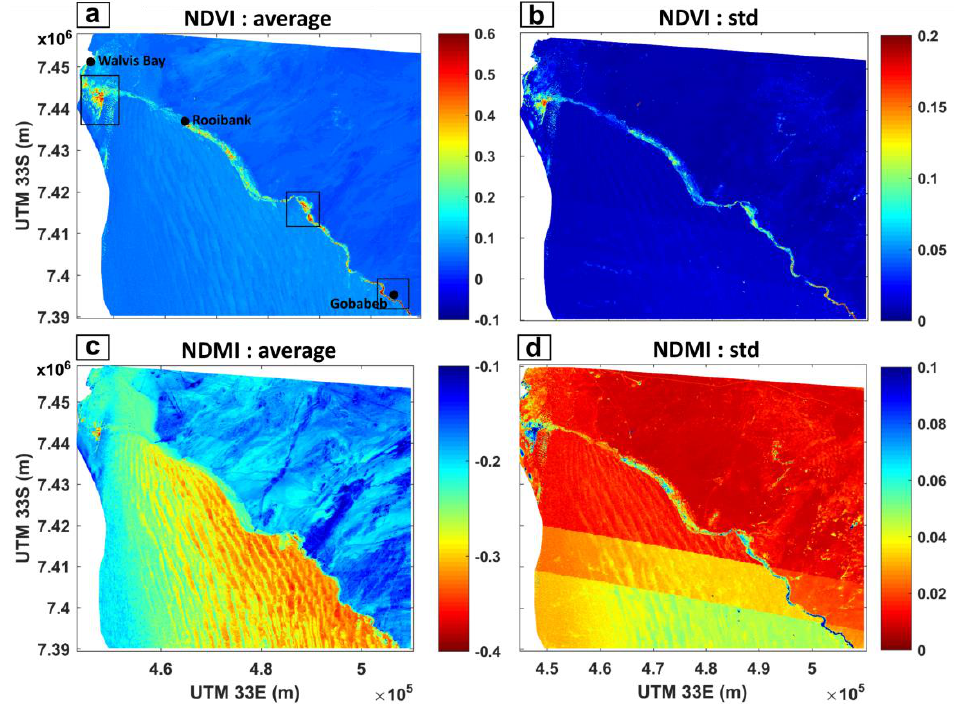
Figure 3. ( a ) Temporal averaged NDVI from Sentinel-2 images with names of major locations, ( b ) associated standard deviation a, ( c ) averaged NDMI from Sentinel-2 images, and ( d ) associated standard deviation. Black boxes in ( a ) show sub-areas selected for the future analysis. Main cities and villages are represented in black.